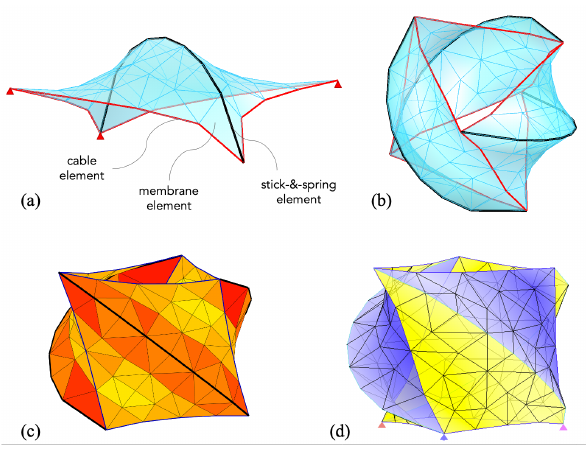
Figure 5: Matlab implementation: model of the cantilevered arch (a); equilibrium configuration of the modified T3 module (b); colormap of the elastic energy of the membrane, higher values at darker colors (c). WinTess check: equilibrium configuration of the same system as obtained in WinTess